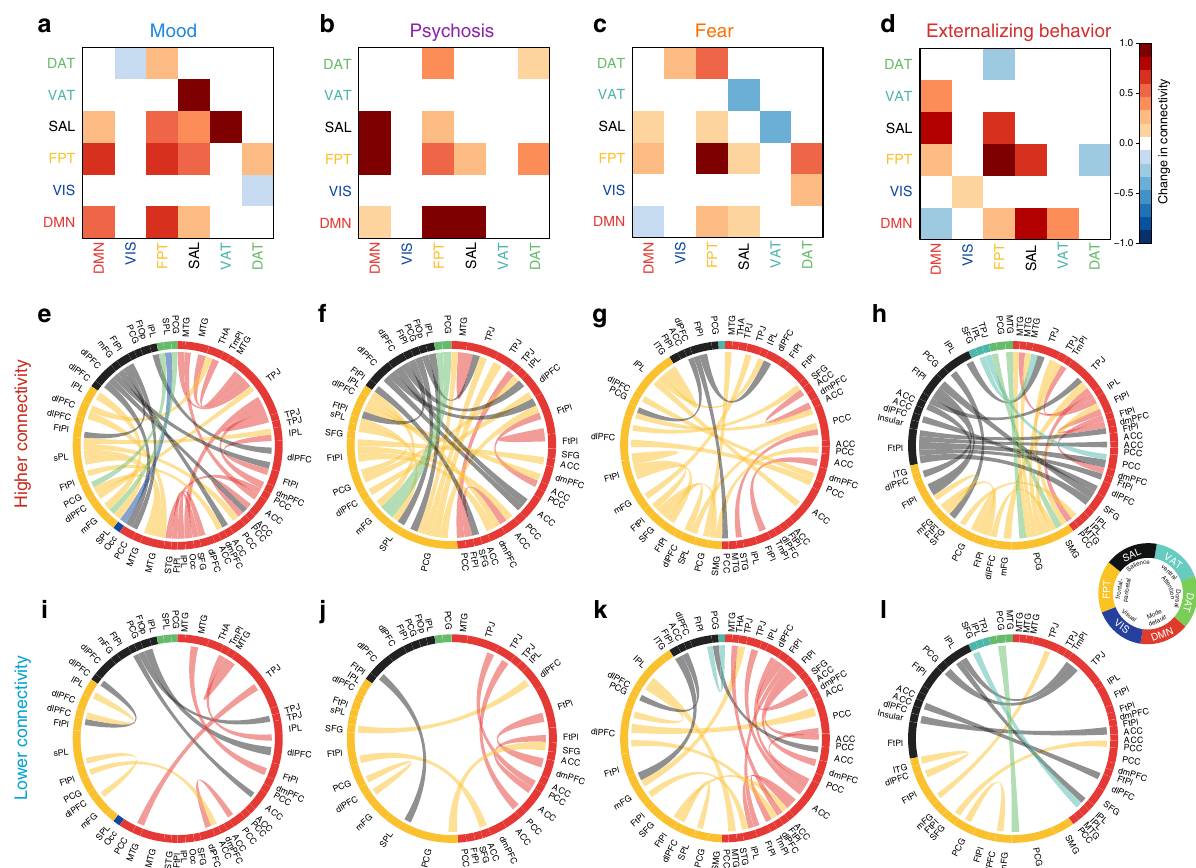
Fig. 5 Patterns of within- and between-network connectivity contribute to linked psychopathological dimensions. a – d Modular (community) level connectivity pattern associated with each psychopathology dimension. Both increased ( e – h ) and diminished ( i – l ) connectivity in speci fi c edges contributed to each dimension of psychopathology. The outer labels represent the anatomical names of nodes. The inner arcs indicate the community membership of nodes. The thickness of the chords represents the loadings of connectivity